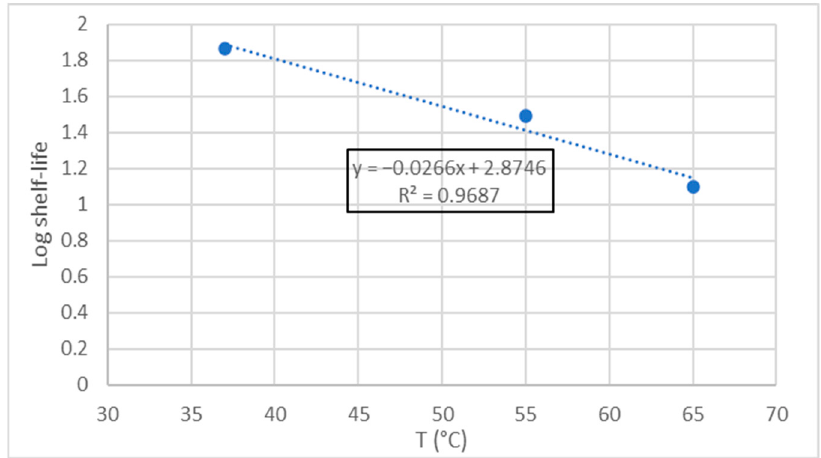
Figure 4. Representation of the shelf-life log as a function of temperature.